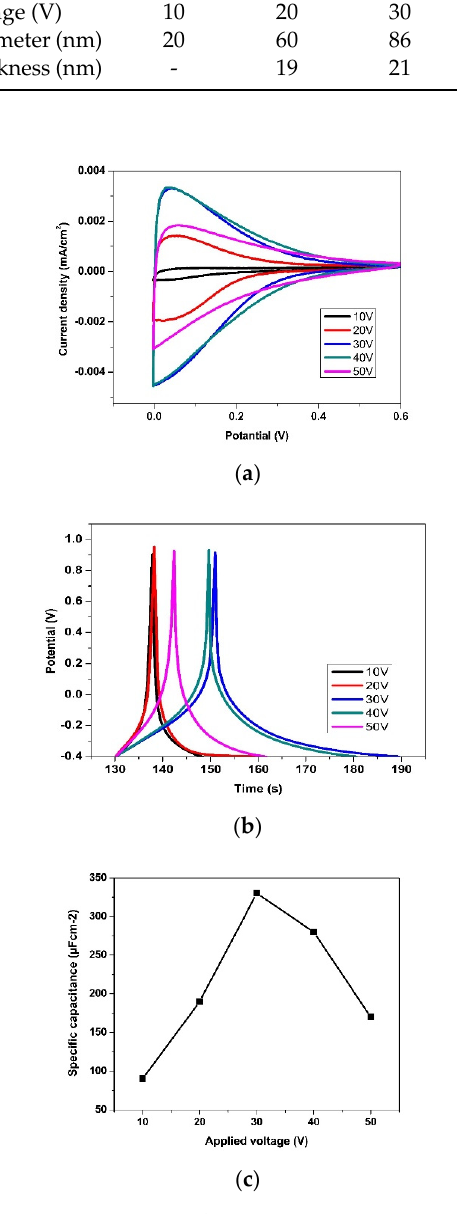
Figure 4. ( a ) CV curves at scan rate of 20 mV s − 1 , ( b ) GCD curves of TNTs at di ff erent applied voltage at current density of 0.02 mA cm − 2 and ( c ) variation of SC with applied